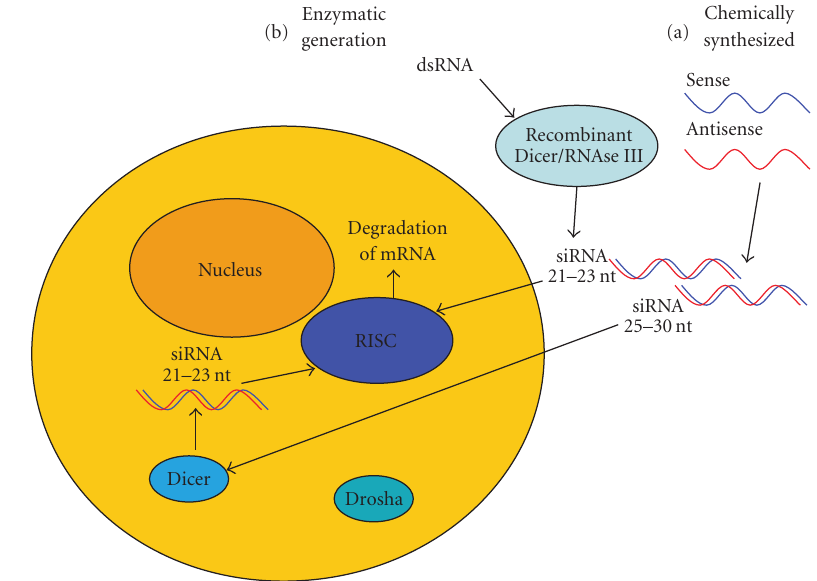
Figure 1: Extracellular generation of siRNA molecules. (a) Sense and antisense strands of RNA are chemically synthesized and annealed to form 21–23 nt or 25–30 nt dsRNA molecules. 21–23 nt siRNA molecules can directly interact with RISC and guide degradation of the corresponding mRNA. 25–30 nt dsRNA molecules must first be cleaved by Dicer to generate the 21–23 nt siRNA molecule which can be loaded into RISC. (b) Recombinant Dicer or RNAse III enzymes can also be used to generate siRNA molecules with silencing capabilities. 21–23 nt siRNA molecules are cleaved from dsRNA and associate with the